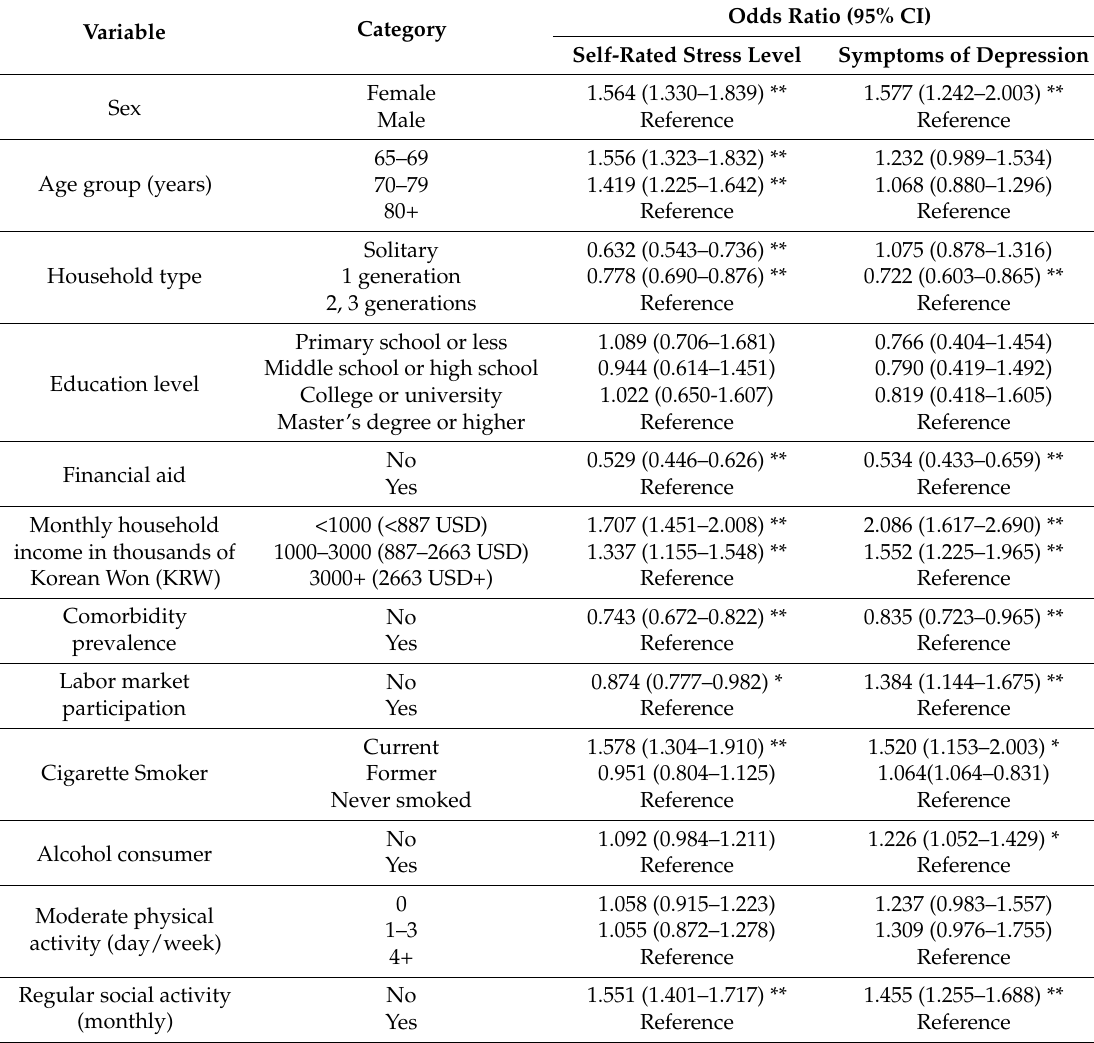
Table 2. Odds ratios (95% Confidence Interval (CI)) of self-rated stress levels and symptoms of depression in relation to sociodemographic characteristics: 2015 Korean community health survey ( n =